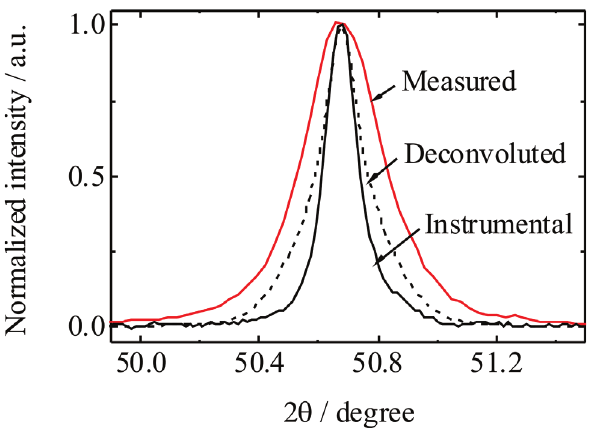
Figure 8: Measured, instrumental, and deconvoluted profiles of 200 reflections of the copper component of the 75% cold-rolled sample.